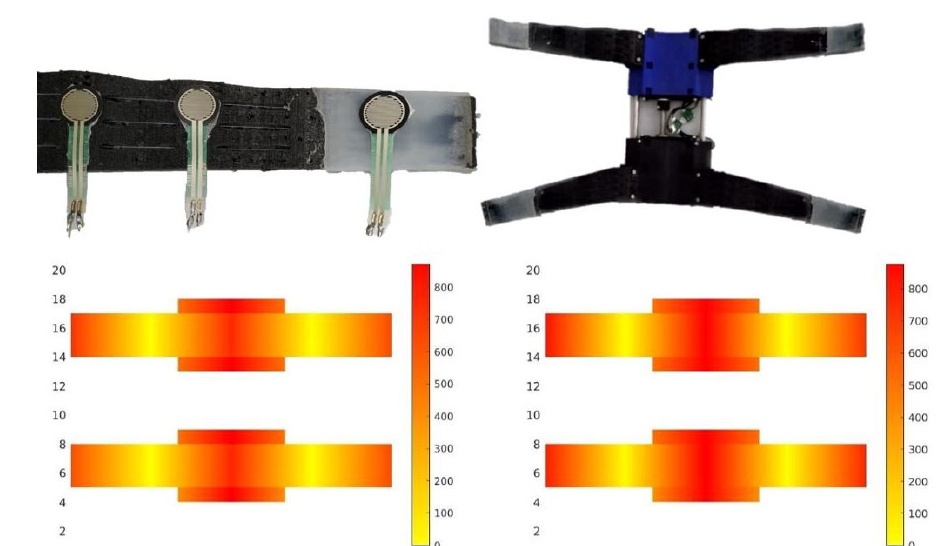
Figure 11. The upper image shows the lower part of the landing gear to which the pressure study is made. The lower left-hand image shows the pressure map made on a 140 mm-diameter pipe and the lower right-hand image shows the pressure map made on a 160 mm-diameter pipe.